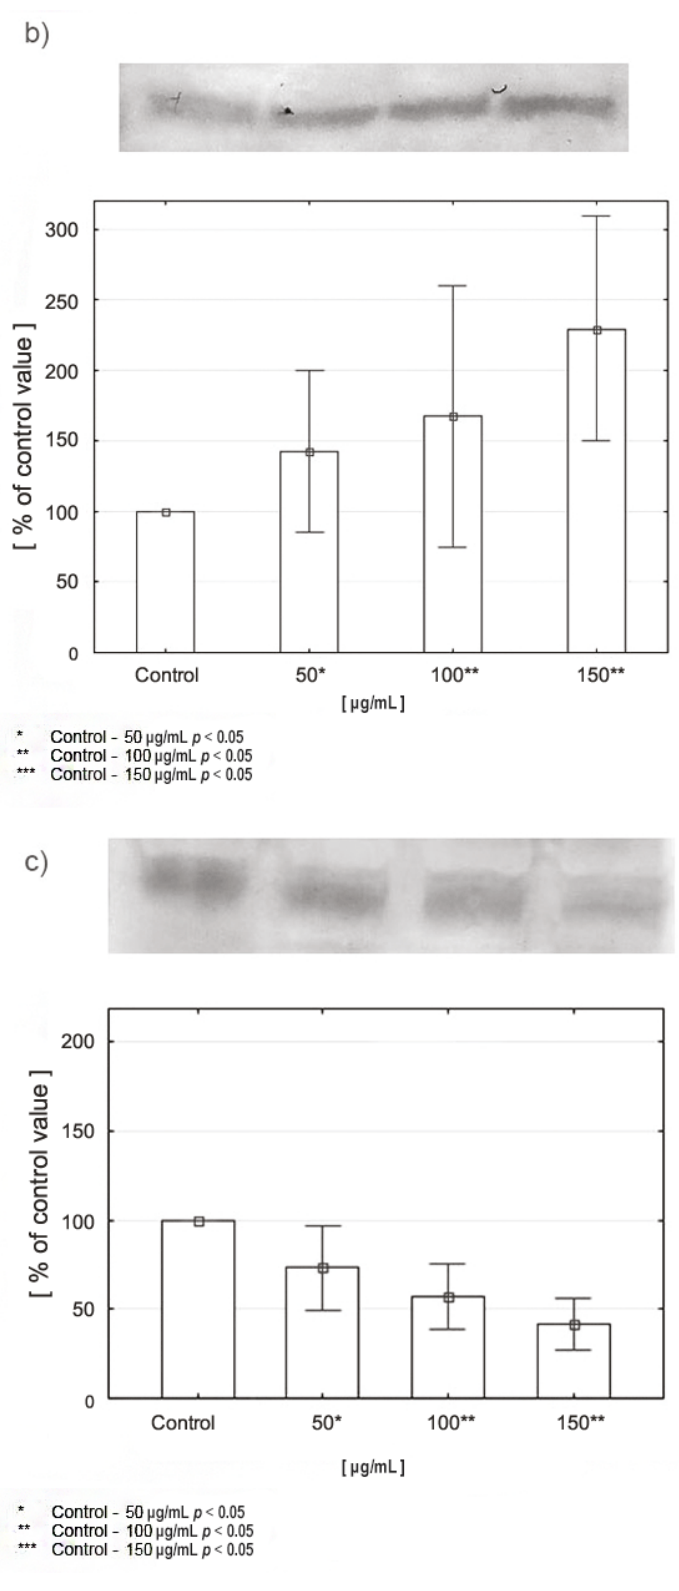
Figure 6. Expression of PRODH / POX ( a ), PPAR γ ( b ), and HIF-1 α ( c ) in CAL-27 cells incubated with various concentrations of celecoxib.